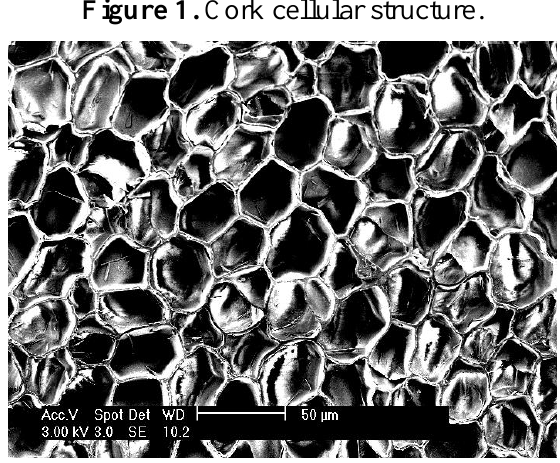
Figure 1. Cork cellular